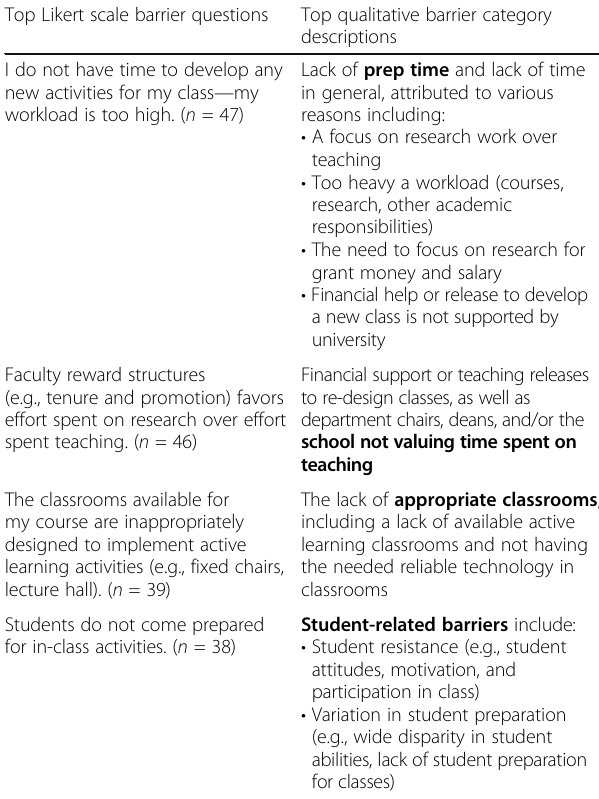
Table 9 Overlap in top reported barriers to instruction from qualitative and quantitative